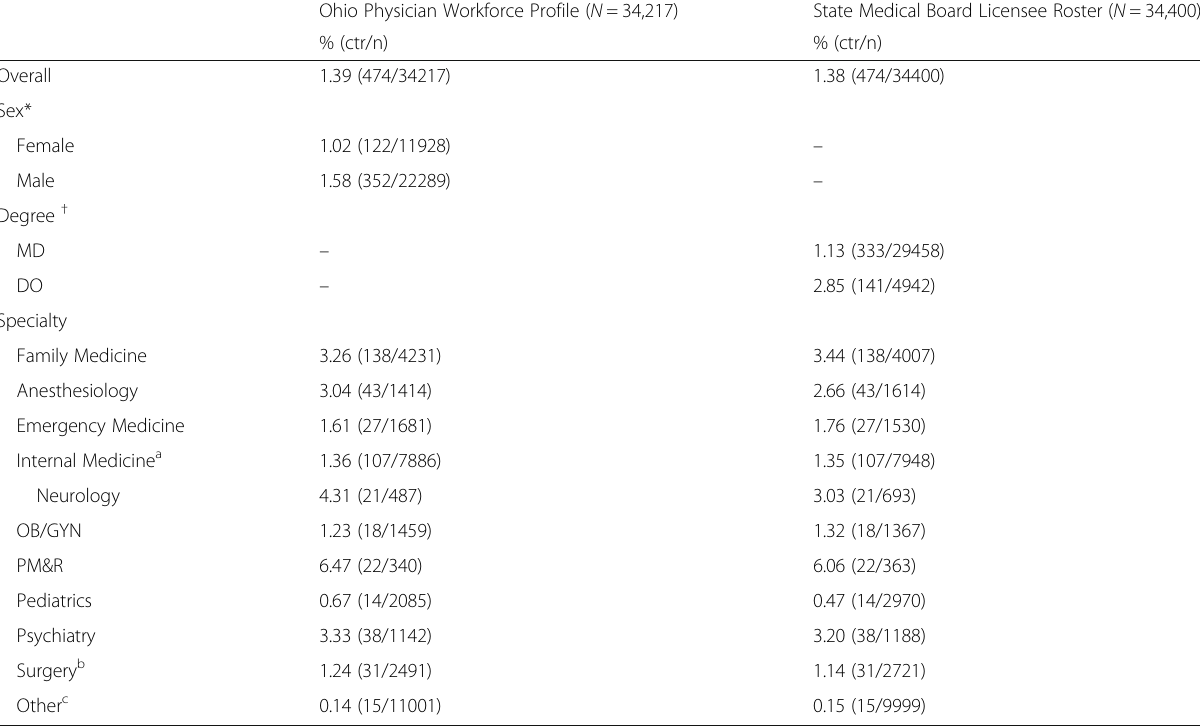
Table 2 Prevalence (per 100 active physicians) of CTR by sex, degree, and specialty comparing the Ohio Physician Workforce Profile and the Ohio Physician Roster